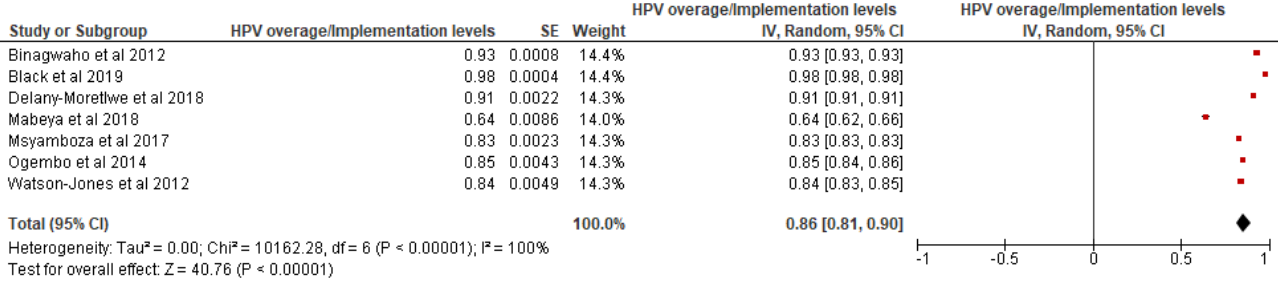
Figure 5. HPV vaccine Coverage: Pilot studies. Source: